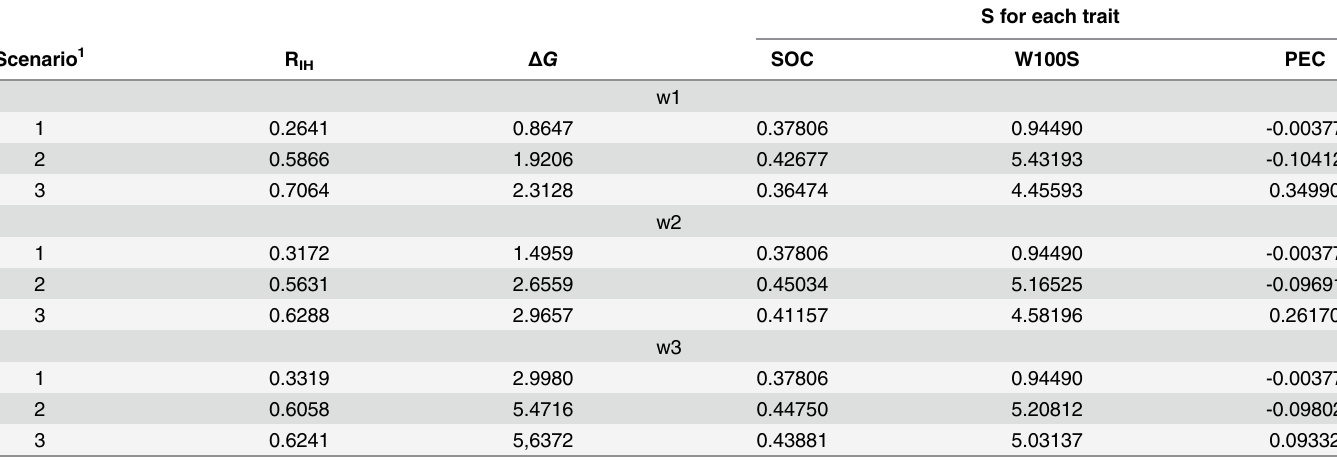
Table 4. Response to selection per generation (S), accuracy of the index (R IH ), and monetary overall genetic gain per generation ( Δ G ) for weight of 100 seeds (W100S, g), seed oil content (SOC, %) and phorbol ester concentration in seeds (PEC, mg/g) using selection